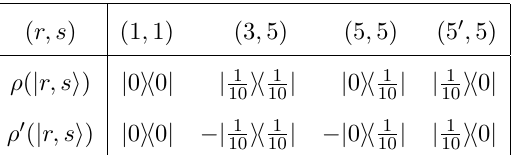
Table 3 . Images of the highest weight